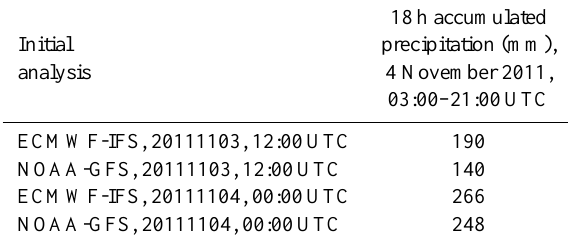
Table 4. As Table 3 but for the GE